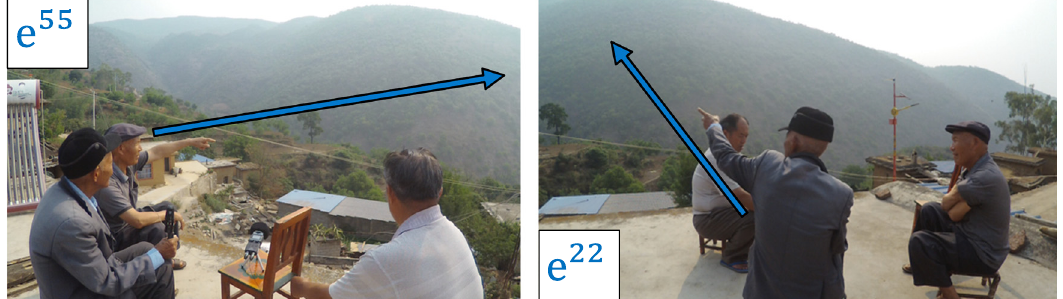
Figure 11: Speaker deictics e ⁵⁵ ‘ this one ’ and e²² ‘ here ’ for far - away villages pointed at and mentally focused by two di ff erent speakers ( each photo corresponds to a di ff erent recording event with a di ff erent sitting arrangement )